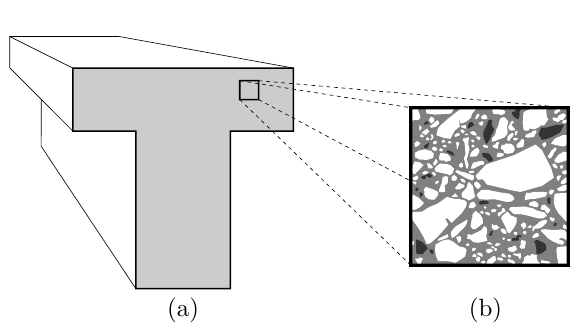
Figure 1. The appearance of the structure at different scales, a) homogeneous at macro-scale, b) heteroge- neous at micro-scale.